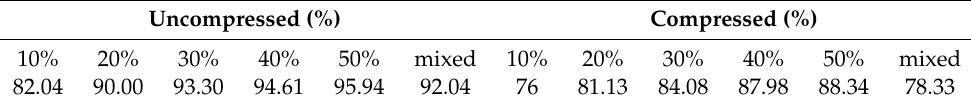
Table 2. The average detection accuracies of our proposed approach with preprocessing.